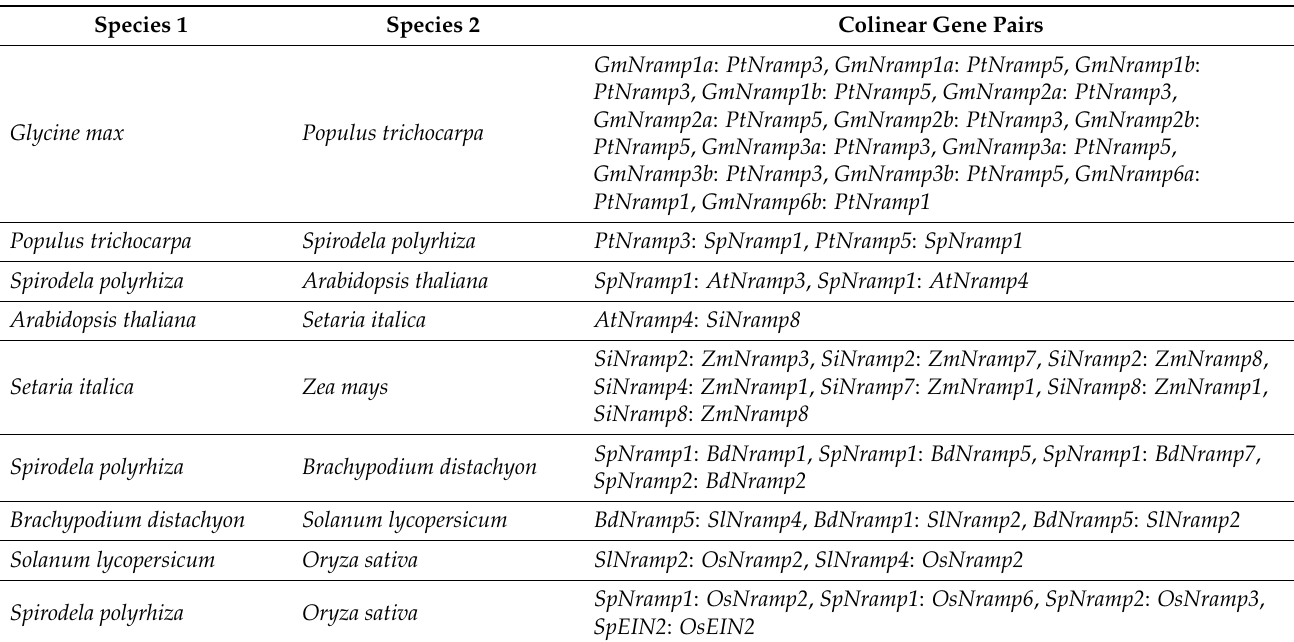
Table 2. The colinear gene